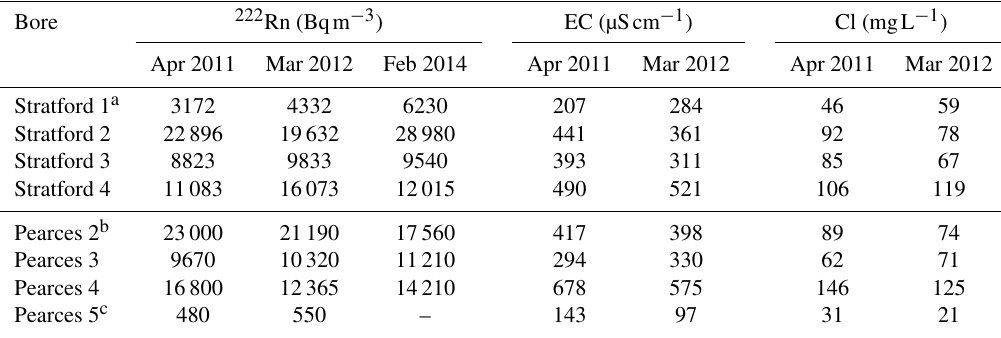
Table A2. Geochemistry of groundwater from Stratford and Pearces Lane.